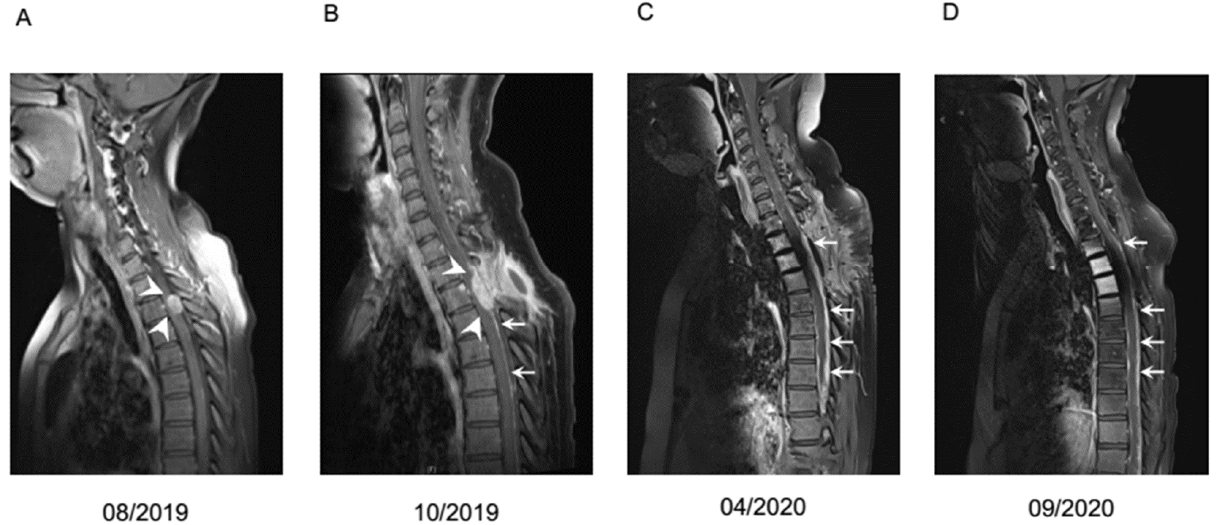
Figure 3. Case example of a patient with leptomeningeal carcinomatosis of a NET G2 with unknown primary, Ki67 20%. Contrast medium enhanced T1 MRI at different timepoints. ( A ) Initial focal meningeal manifestation (white arrowheads) which was locally resected. ( B ) First local recurrence (white arrowheads) with diffuse meningeal enhancement (white arrows), treated with resection and additive irradiation. ( C ) Second recurrence with diffuse nodular meningeal enhancement (white arrows). Liquor analysis showed pleocytosis of 14/µl with 50% tumor cells and signs of blood brain barrier dysfunction. Systemic chemotherapy with carboplatin and etoposide was initiated in April 2020. ( D ) Imaging after four cycles of carboplatin and etoposide revealed slightly regressive tumor manifestations. However, because of progressive neurological deterioration and hematologic toxicity, a switch to treatment with capecitabine and temozolomide was recommended. Deterioration of clinical situation proceeded rapidly, so the patient could not receive the planned chemotherapy and passed away in December 2020.